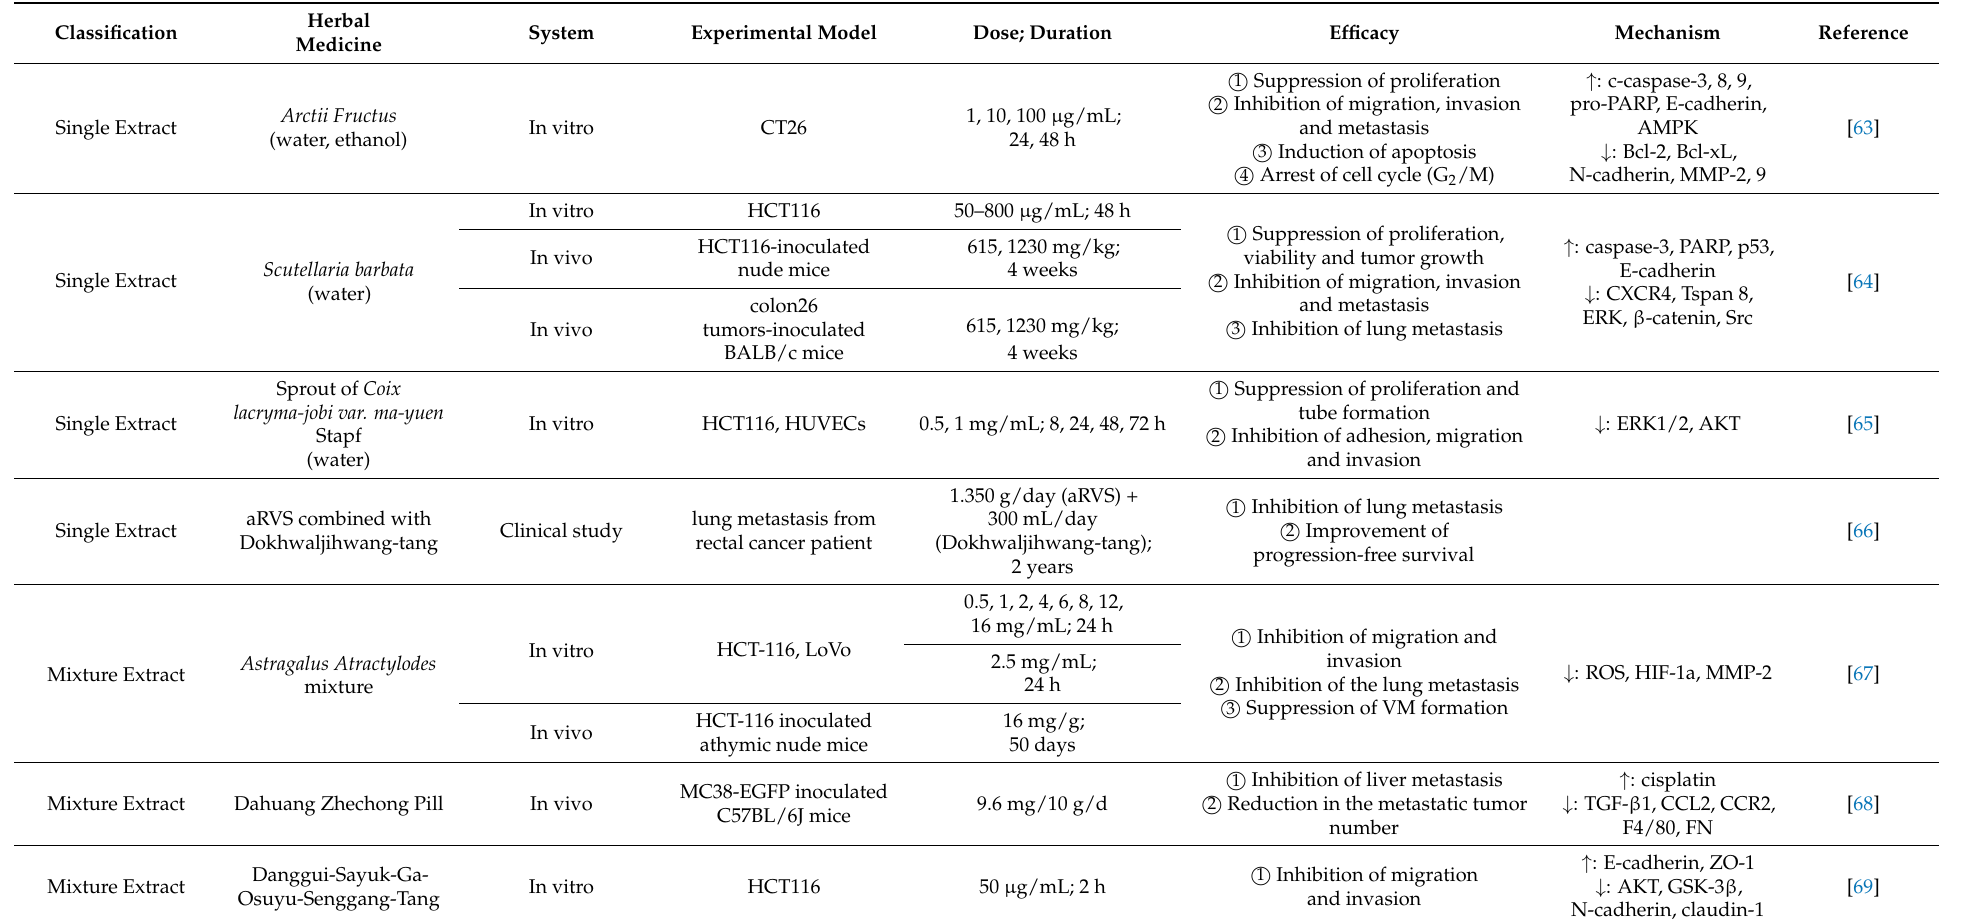
Table 3. Colorectal